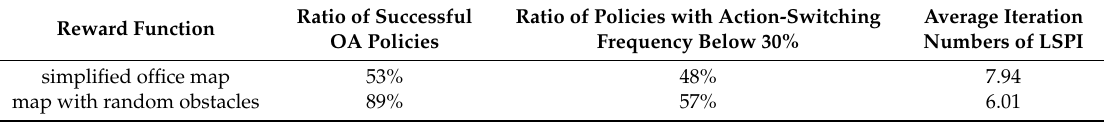
Table 8. Comparison of different types of training